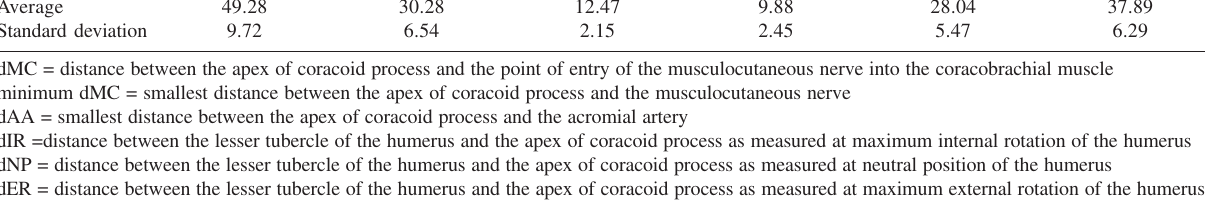
Table 1 - Distances (mm) between the apex of coracoid process and the anatomical structures analyzed dMC